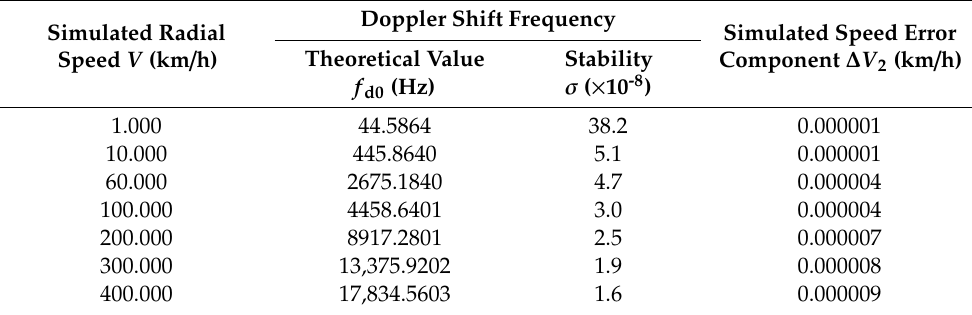
Table 5. Doppler shift frequency stability and simulated speed error component in the stability aspect of the second moving target simulator at emitted frequency of 24,060